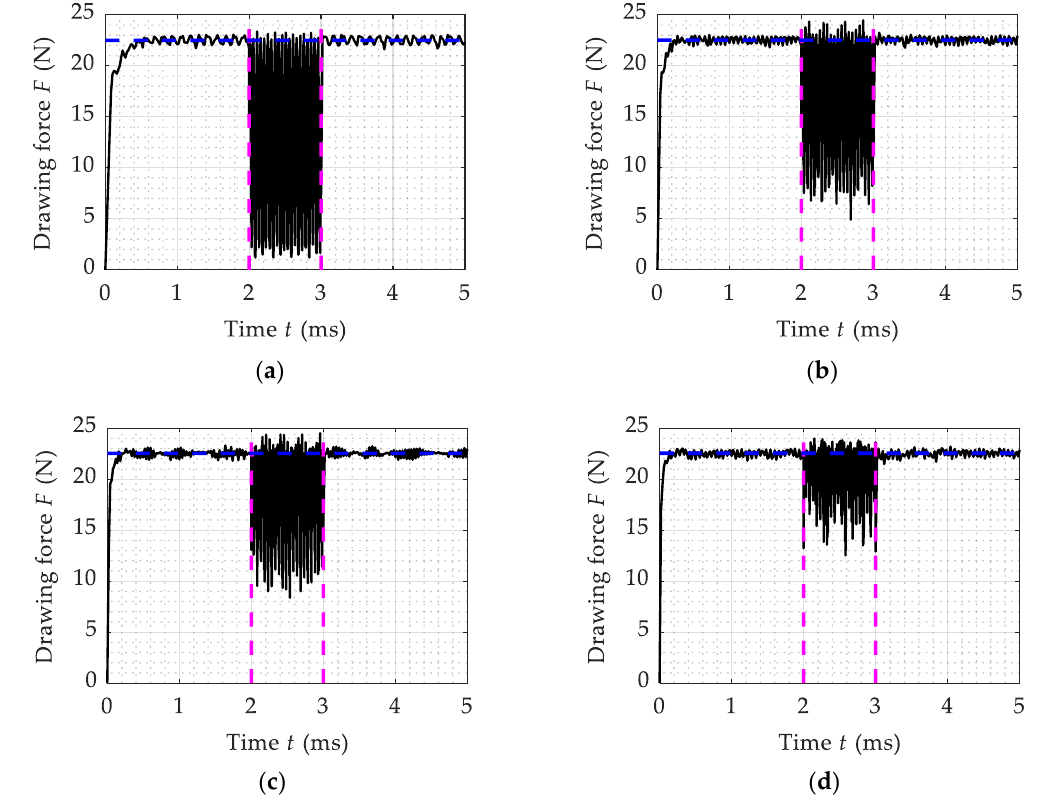
Figure 8. Influence of drawing speed on time-variation of the drawing force with reel-die distance of 7.9 mm: ( a ) V = 200 mm/s ; ( b ) V = 400 mm/s ; ( c ) V = 600 mm/s ; ( d ) V = 800 mm/s .